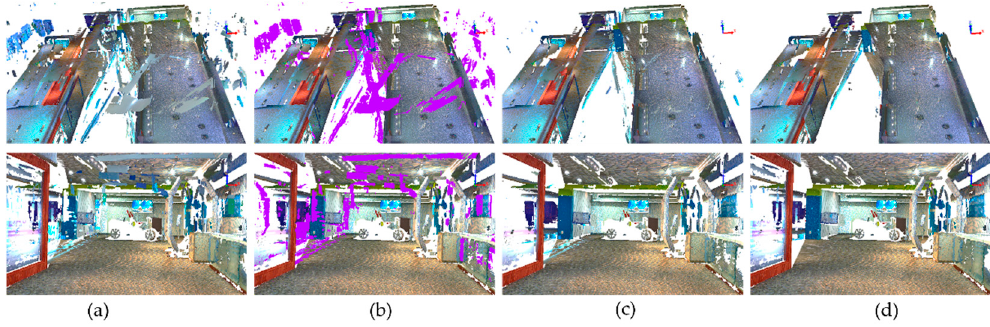
Figure 14. Comparison of our proposed method result and ground truth. ( a ) is the original point cloud, ( b ) is the noise detection result, the purple part of the figure, ( c ) is the point cloud after denoising using our method, and ( d ) is ground truth data by manual denoising.